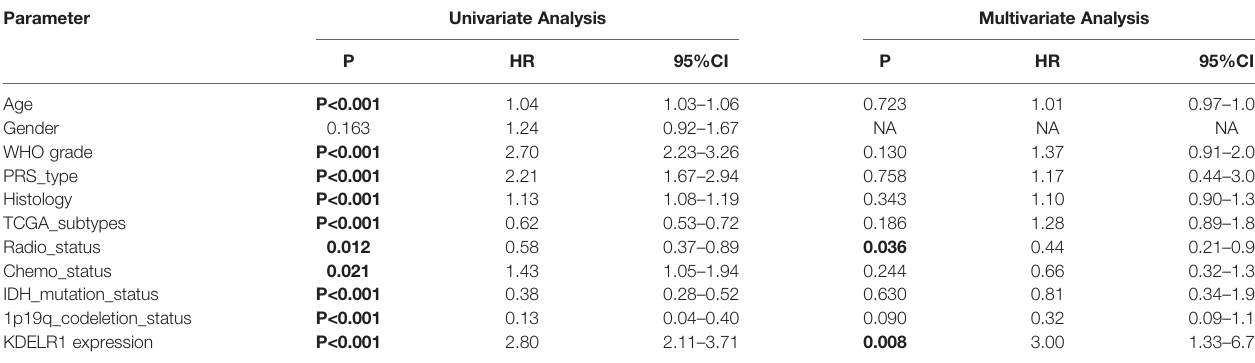
TABLE 1 | Cox regression analysis of KDELR1 expression as an independent survival predictor of gliomas in CGGA mRNA-array_301. Parameter